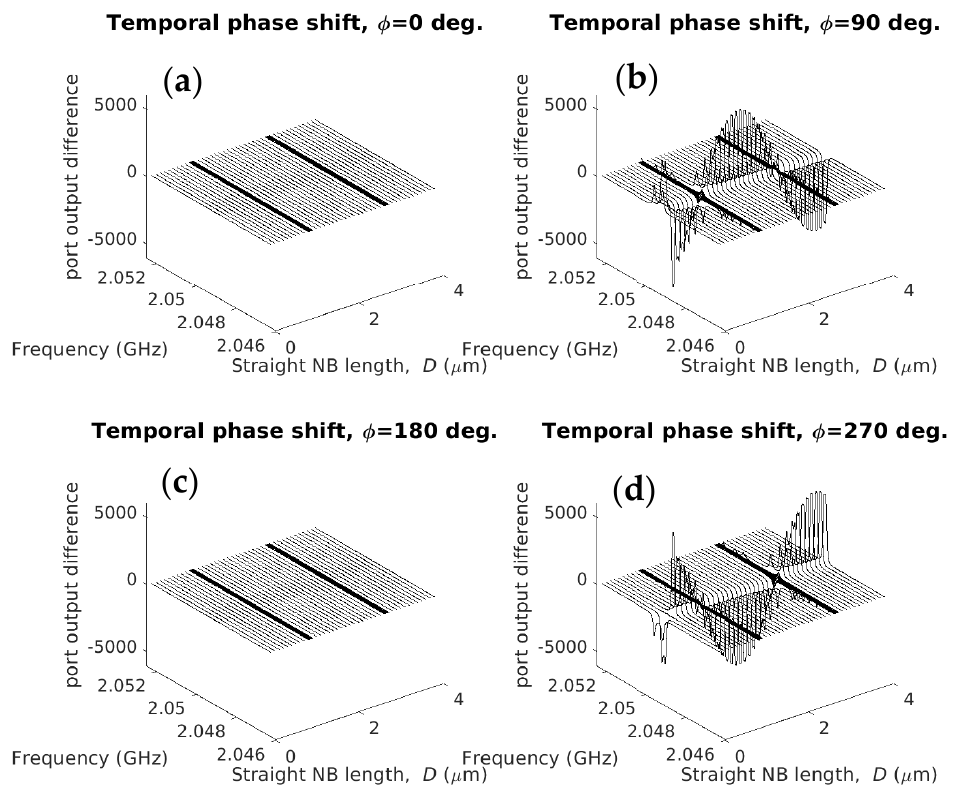
Figure 8. Spectra of the difference between ports P 1 and P 2 in shape B “ − o 4 × o 4 − < D > − o 4 × o 4 − ” as a function of the straight nanobeam length D , for four principal values of the temporal phase shift between two sources in the cavity centers ( a – d ).